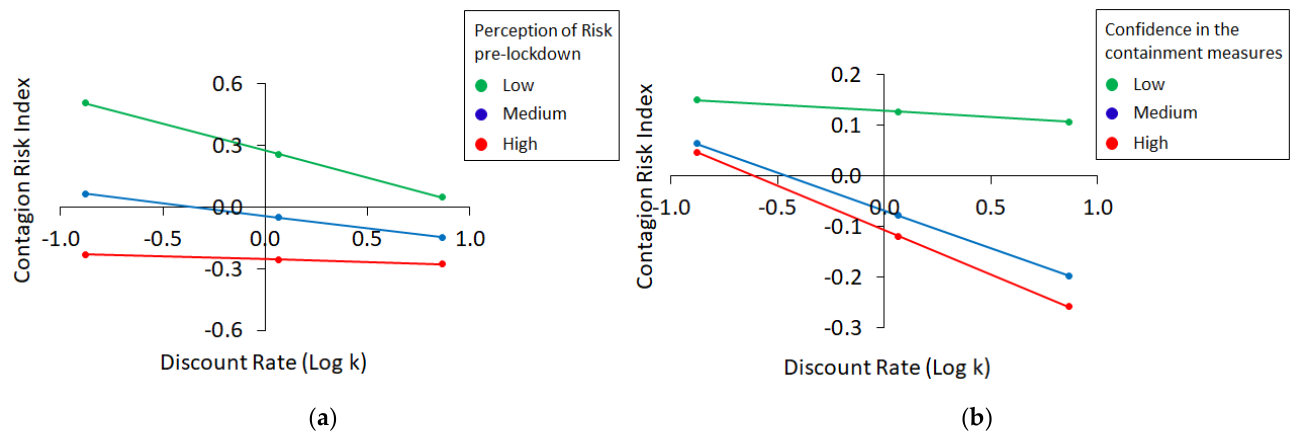
Figure 2. Results of the moderation models conducted using the Contagion Risk Index as dependent variable, the discount rate (k) as independent variable and the perception of risk pre-lockdown ( a ) or the confidence in the effectiveness of the containment measures ( b ) as moderators.